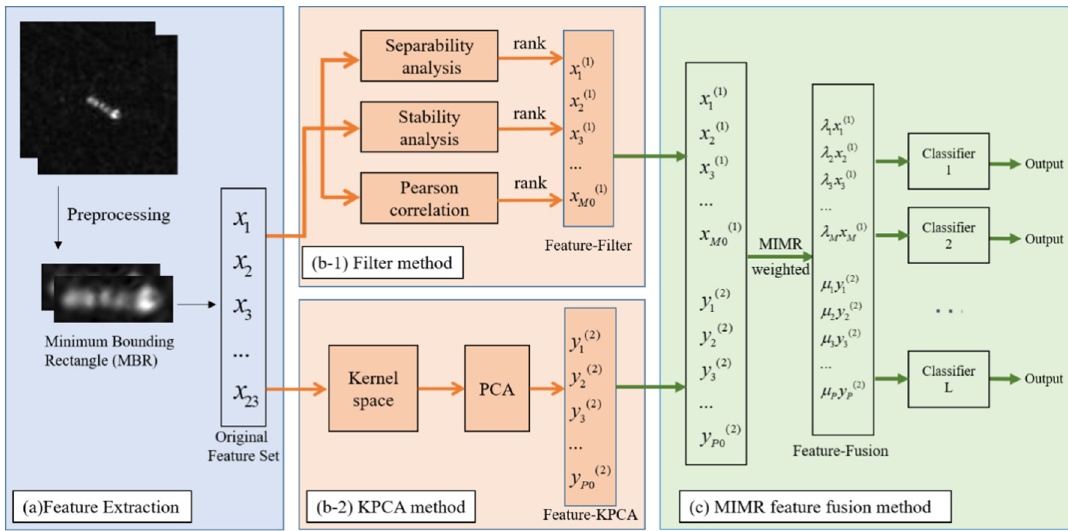
Figure 1. Overall block diagram based on the maximum-information-minimum-redundancy (MIMR) multi-feature fusion framework.